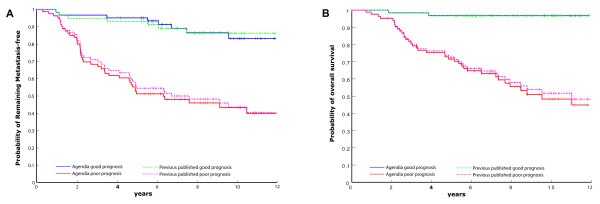
A. Kaplan-Meier Analysis of the probability that patients would remain free of distant metastases among 145 patients with lymph-node-negative breast cancer. Blue: Current Good prognosis profile group; green dashed: Good prognosis profile group; Red: Current Poor prognosis profile group; Magenta dashed: previous published data [13] Poor prognosis profile group. B. Kaplan-Meier Analysis of the probability of overall survival among 145 patients with lymph-node-negative breast cancer.